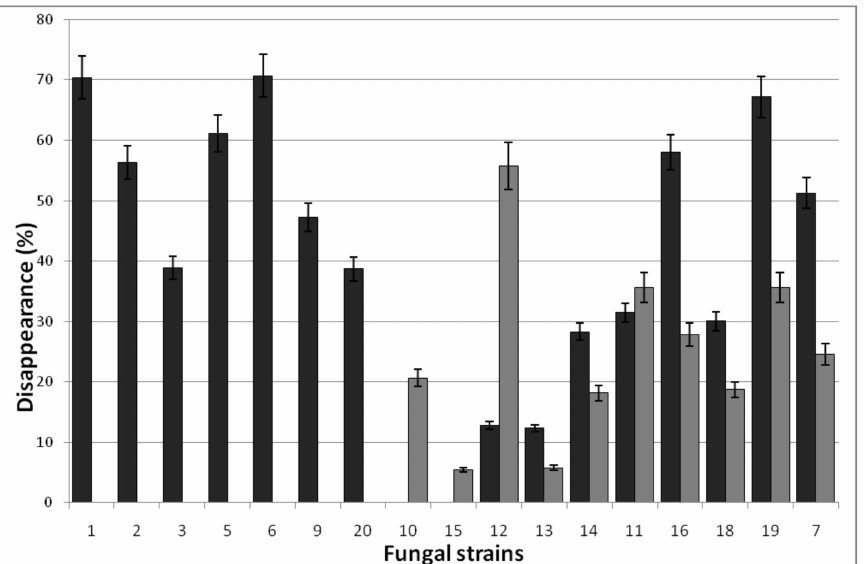
Figure 4. The disappearance of neonol AF9-12 by studied fungi: 1— P. ostreatus f. Florida, 2— P. Figure 6. Effect of PAHs and their fungal metabolites on germination of seeds ( □ ), length of shoots ( ■ ), and length of roots ( ■ ) of sorghum: ANT—anthracene, ANTQ—9,10-anthraquinone, PHE— phenanthrene, PHEQ—phenanthrene-9,10-quinone, FLU –fluorene, FLU-on—9-fluorenone, CBA— 2-carboxybenzaldehyde, DIPH—2,2 ′ -diphenic acid, PHTH—phthalic